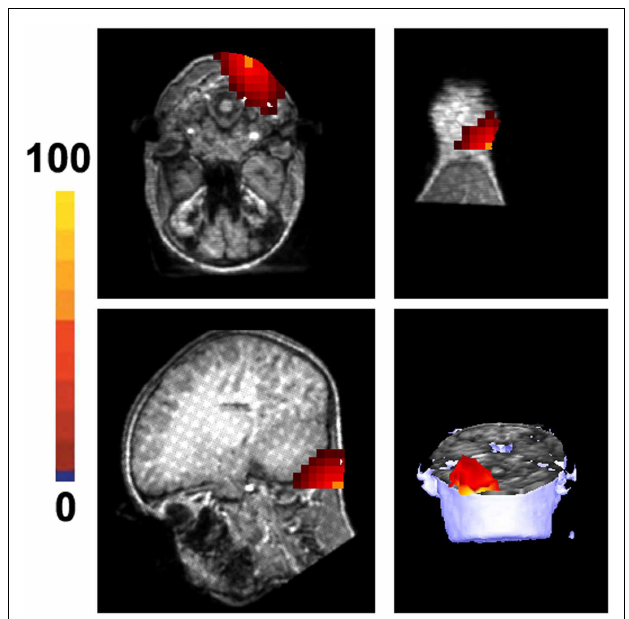
FIGURE 6 | Magnetic source images show the location of noise in 1000–2000Hz in a healthy subject .The noise is from the occipital region and is considered to result from muscle artifacts. Of note, the location of the strongest noise is aligned with the neck and is outside of the brain.The color bar indicates the strength of muscle activity, which is a statistical value that does not have a specific